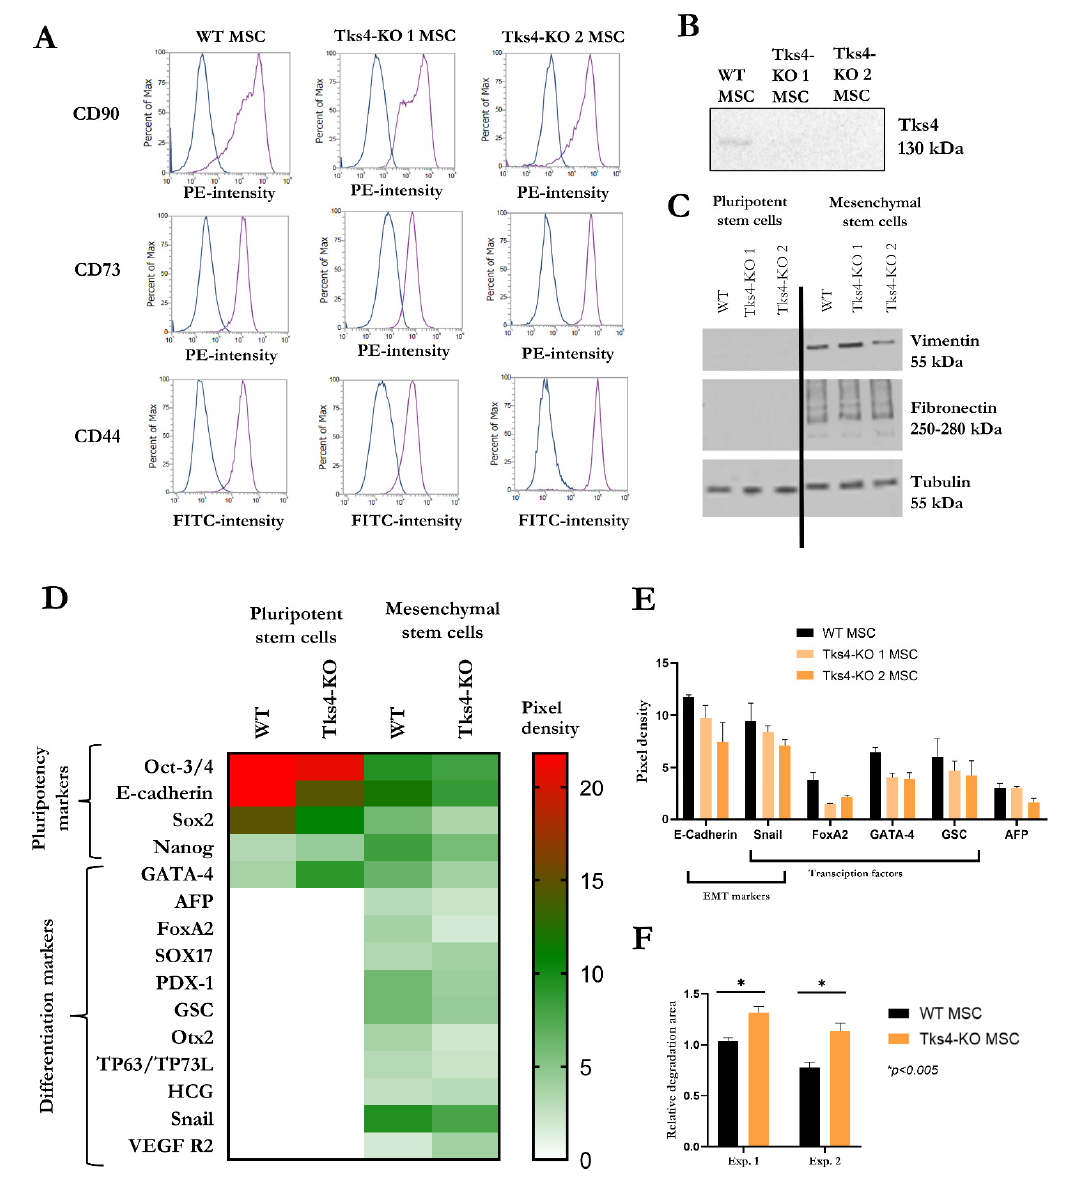
Figure 3. ( A ) Representative flow cytometry histograms showing CD90, CD72, and CD44 staining of WT (WT) MSC and the two Tks4-KO MSC clones. (Blue lines represent the isotype control labelling); ( B ) Representative western blot showing the presence of Tks4 in WT MSC cells and the lack of Tks4 protein in Tks4-KO MSC clones; ( C ) Western blot analysis of the EMT (and differentiation) markers Vimentin and Fibronectin in pluripotent stem cells (WT and Tks4-KO) and the generated MSC (WT and Tks4-KO) lines; ( D ) Heatmap comparing the proteome profiler stem cell array results of the pluripotent stem cells (WT and Tks4-KO) and the generated MSC (WT and Tks4-KO) lines. The two Tks4-KO clones were measured separately but the obtained data sets were combined and the averages of two independent biological samples were presented; ( E ) Protein levels of early differentiation markers (E-cadherin, Snail, FoxA2, GATA4, goosecoid (GSC), AFP) measured in WT and Tks4-KO MSC lines analysed separately in the two Tks4-KO MSCs; ( F ) Results of the gelatinase assay (repeated twice: Exp. 1 and Exp. 2) showing the degradation activity of the WT MSC line and the average of the two Tks4-KO MSC lines. The figure shows the quantitation of the relative degradation area (dark area of the FITC-gelatine surface) per cell area (TRITC-Phalloidin labelling). Student’s unpaired t -test was used for the statistical analysis. * p <